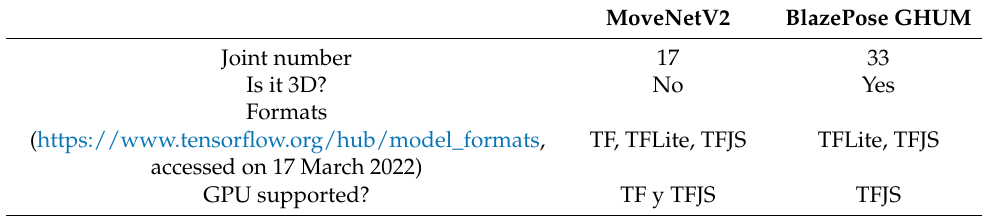
Table 2. Characteristics of the pose estimation models considered.